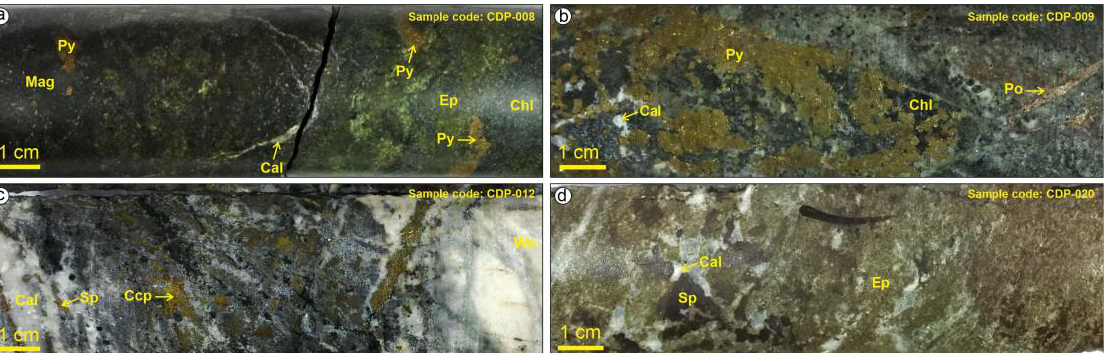
Figure 3. Representative drill core samples from Ruwai: ( a ) massive magnetite – epidote skarn; ( b ) disseminated pyrite-pyrrhotite in altered wall rock; ( c ) disseminated chalcopyrite-sphalerite in marble; and ( d ) disseminated sphalerite in epidote skarn. Abbreviations: Py: pyrite; Mag: magnetite; Ep: epidote; Cal: calcite; Chl: chlorite; Sp: sphalerite; Ccp: chalcopyrite; Po: pyrrhotite.